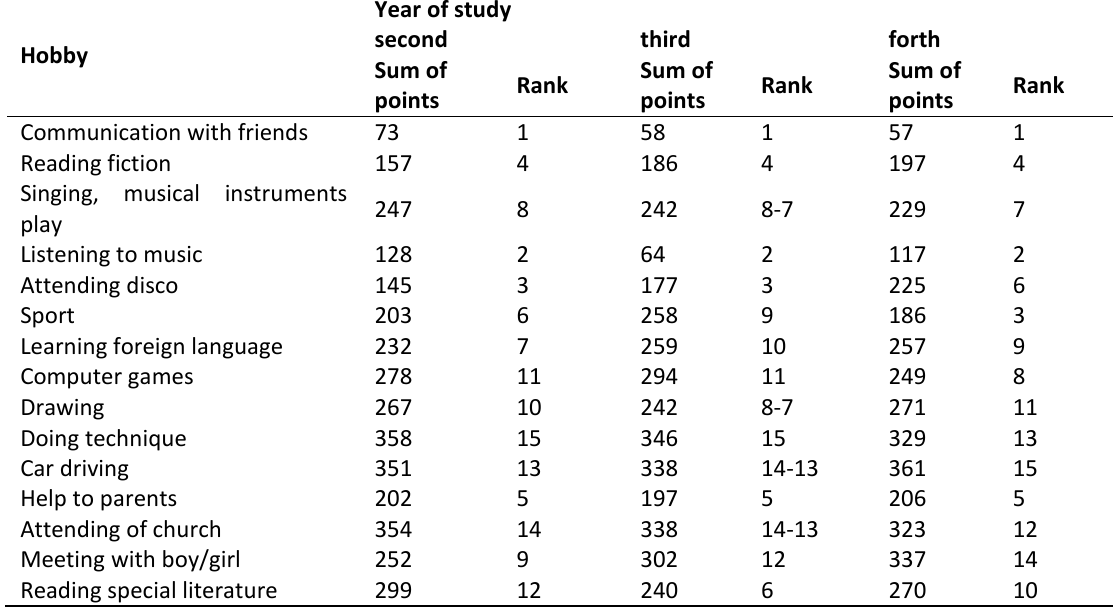
Table 2. Leisure preferences of different years’ pedagogic specialties girl